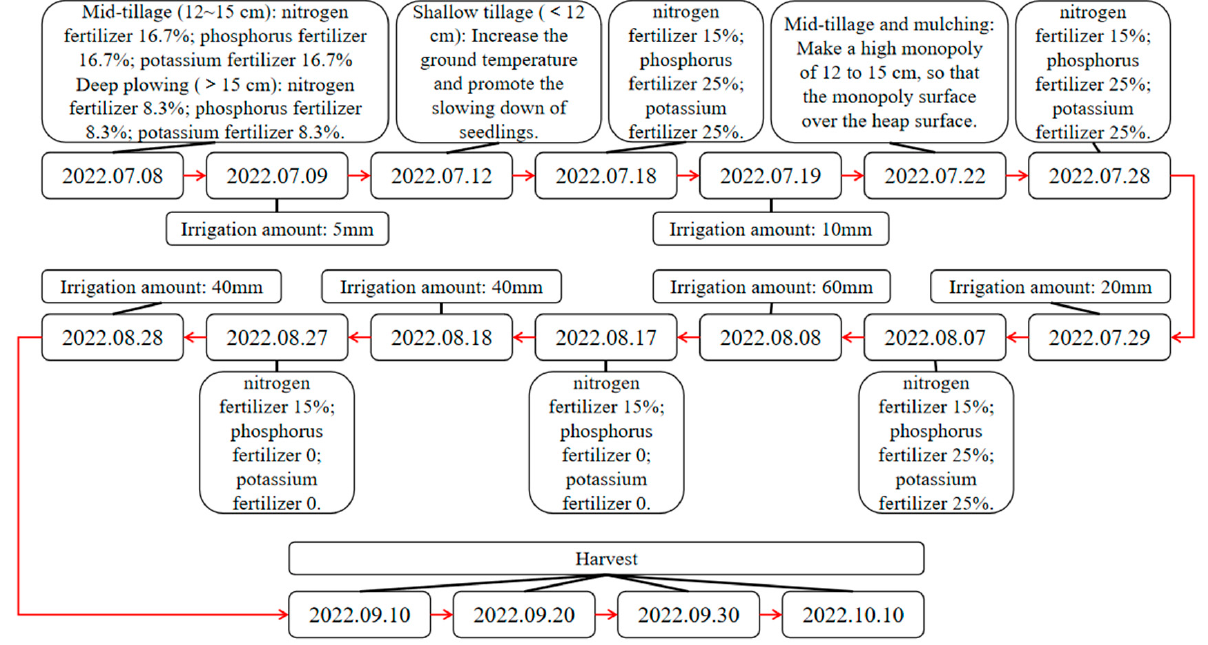
Figure 2. Specific experimental process.